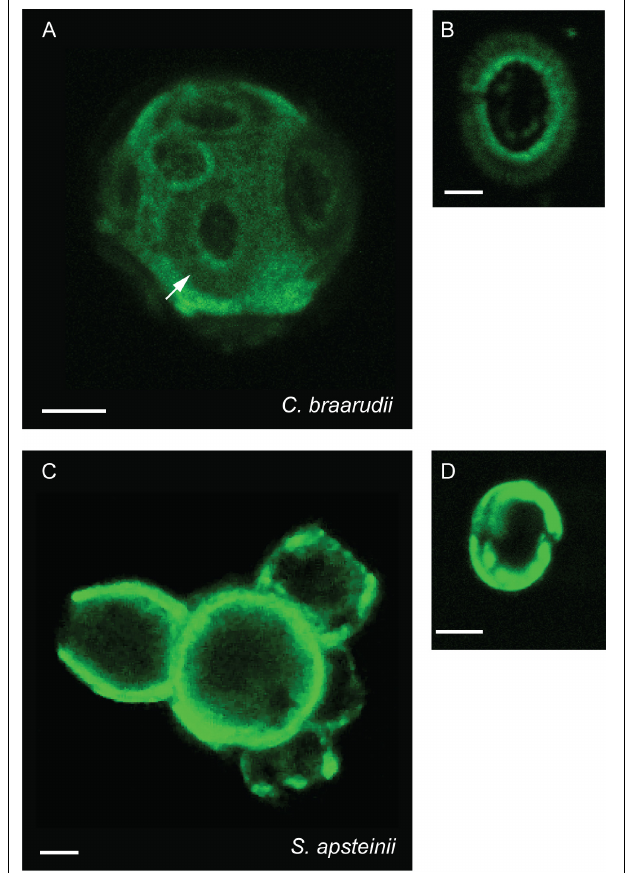
FIGURE 3 | Polysaccharides associated with coccosphere. Confocal microscopy imaging of calcified coccolithophores stained with the lectin FITC-ConA. (A) z-stack projection of a calcified C. braarudii cell. Distinct coccolith shaped details are apparent (arrowed). (B) Discarded coccolith from C. braarudii . (C) z-Stack projection of a calcified S. apsteinii cell showing polysaccharide associated with the coccoliths (arrowed). (D) Discarded murolith from S. apsteinii. Scale bars represent 5 µ m (A,C) and 2 µ m (B,D)